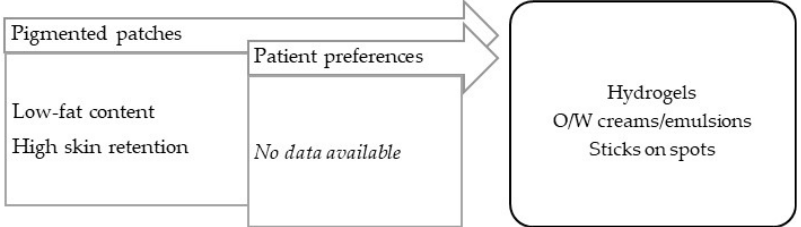
Figure 8. TPP for formulations for treatment of pigmentation disorders and most suitable vehicles/bases.